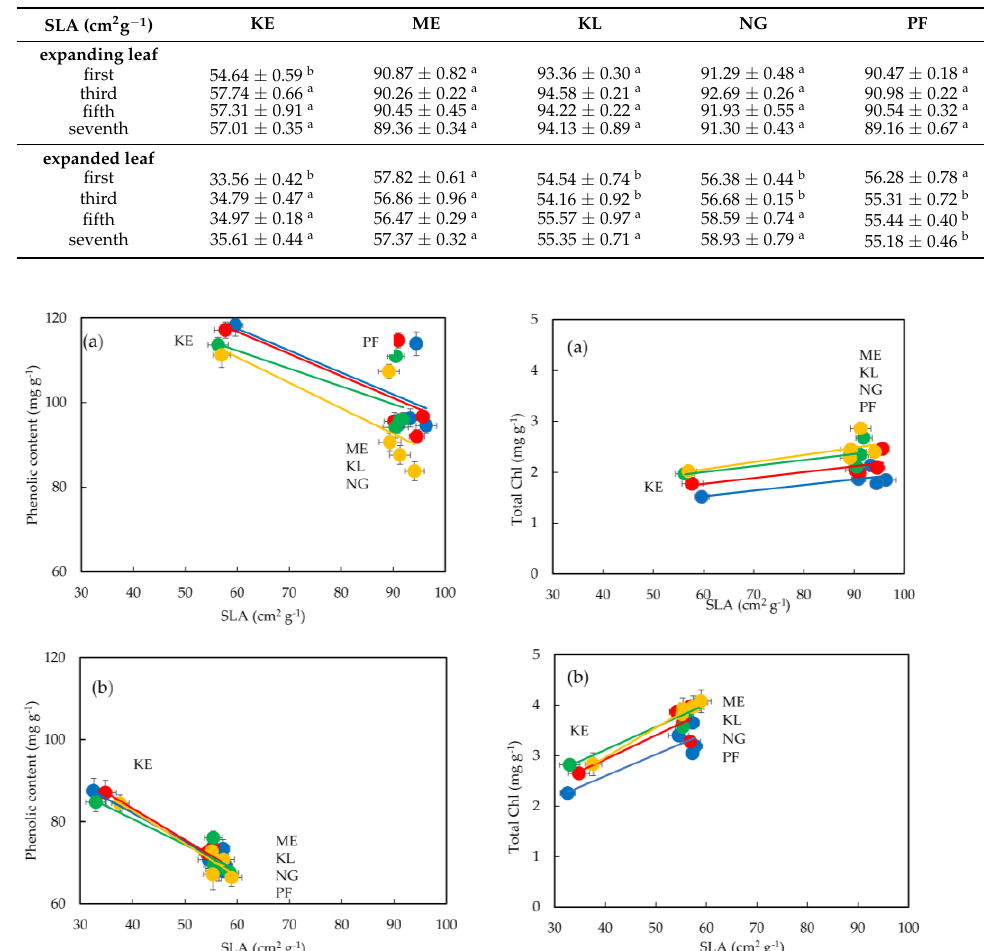
Figure 4. Linear correlation of specific leaf area (SLA) versus phenolic ( left ) and chlorophyll ( right ) content in expanding ( a ) and expanded ( b ) compound leaves of C. siliqua ; blue circles indicate the first leaf, red circles indicate the third leaf, green circles indicate the fifth leaf, and yellow circles indicate the seventh leaf. The five sampling sites are indicated by initials; four of them (PF, NG, KL and ME) are within the urban fabric, while KE is on the suburban site on Hymettus Mountain. The results are means (see Sections 4.5, 4.6 and 4.7) ± standard deviation.